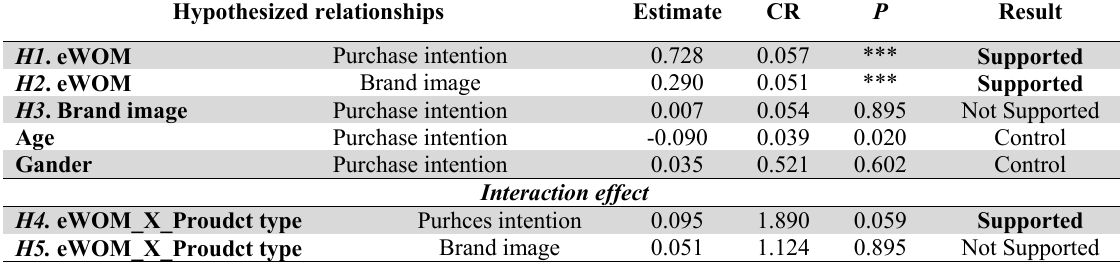
Results of the structural model for the direct relationships among constructs Hypothesized relationships Estimate CR P